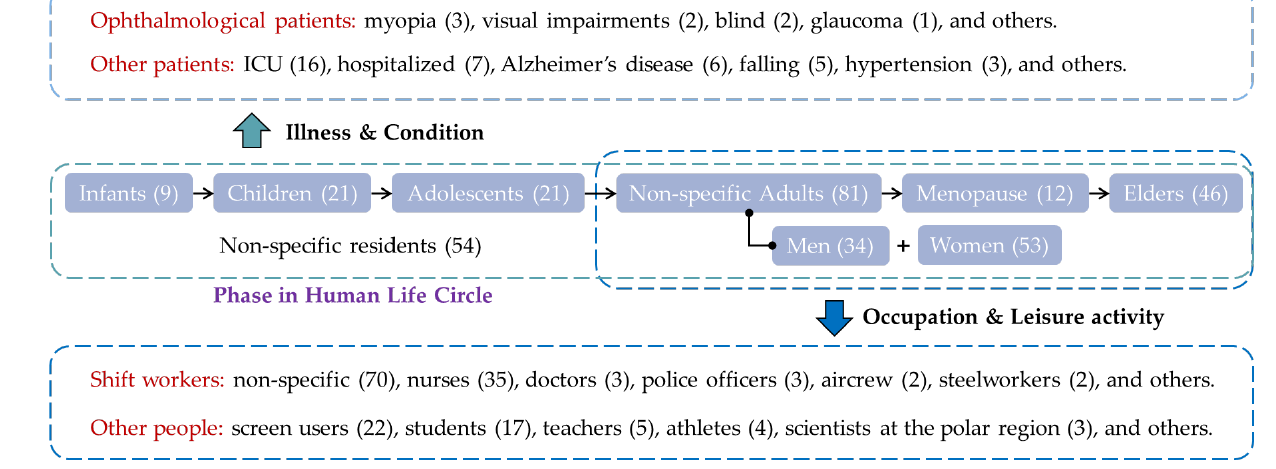
Figure 5. Differentiated vulnerable groups to ALAN’s effects. The number of relevant articles is enclosed in parentheses. enclosed in